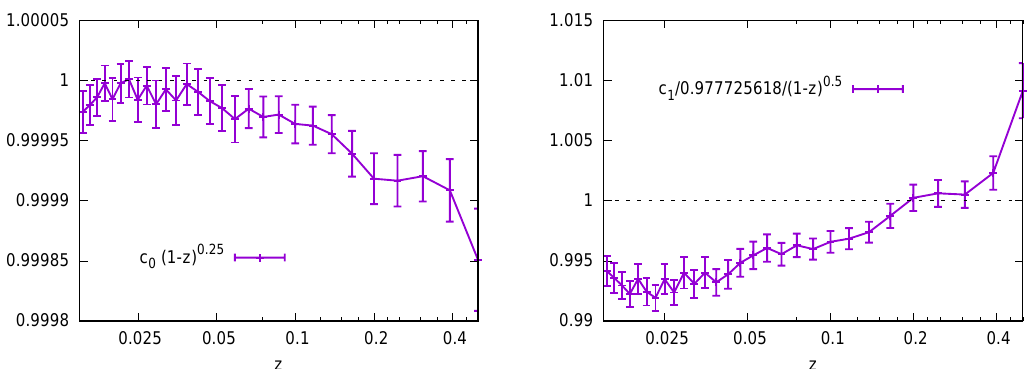
Figure A.7: Rescaled four-point correlation function r for Q = 1,2,3 as a function of r .